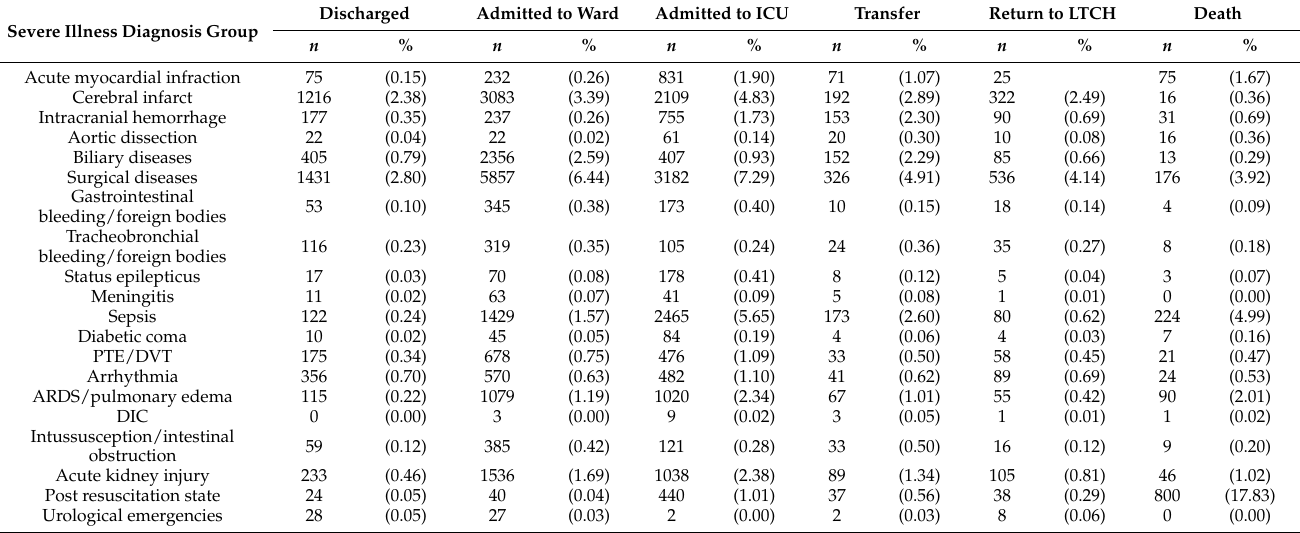
Table 5. Percentage of patients with severe illness diagnosis codes by disposition results in EDs for LTCH group.